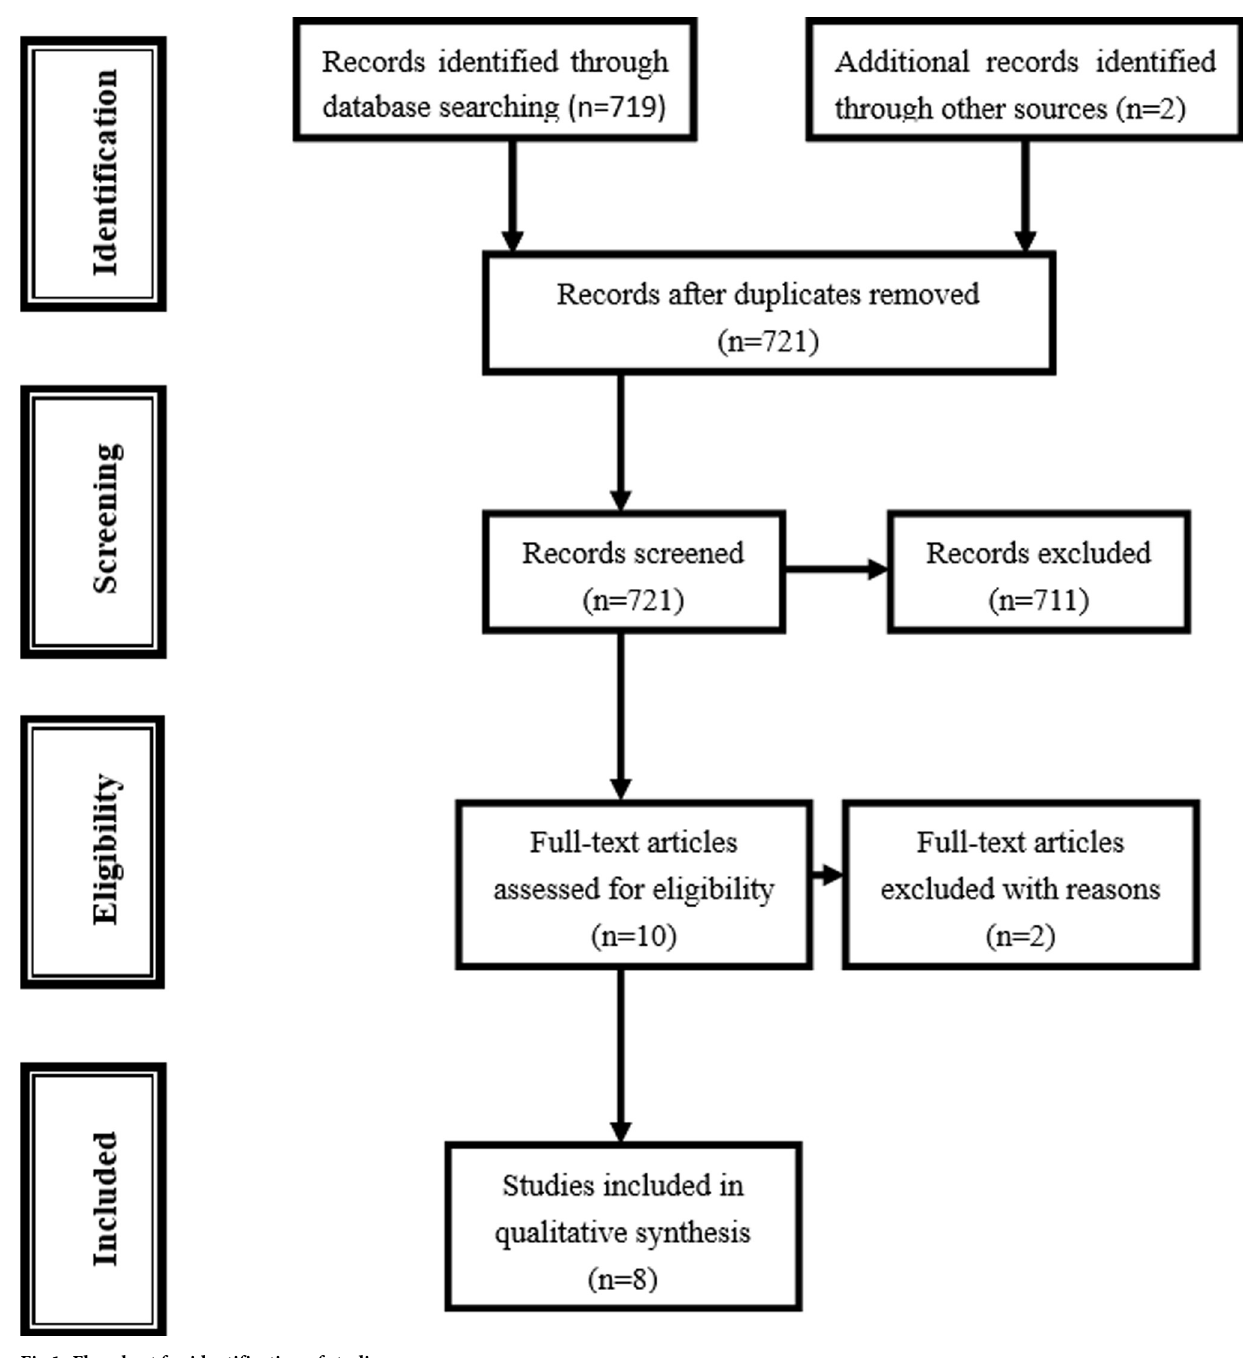
Fig 1. Flowchart for identification of